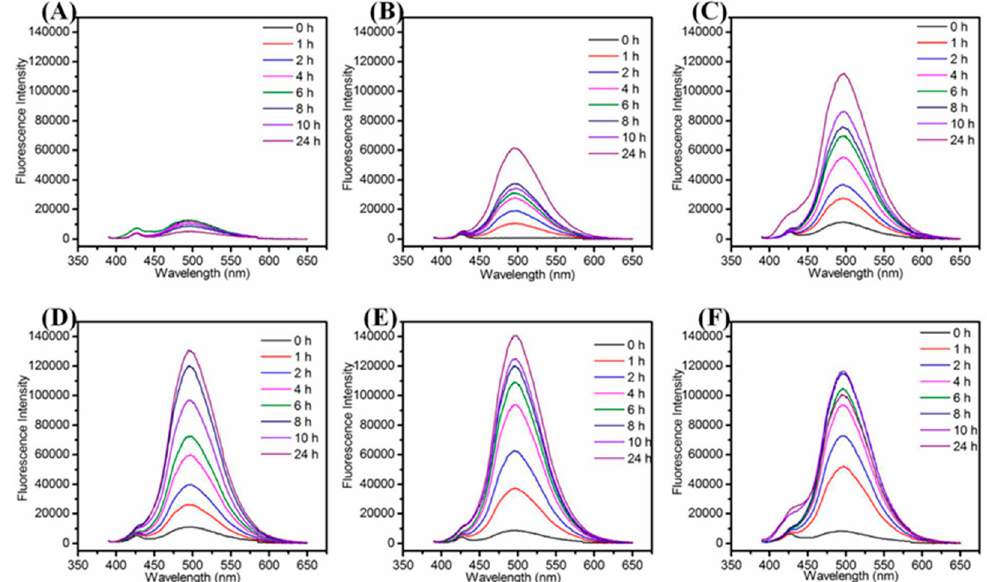
Figure 2. Fluorescence emission spectra of Cu NCs@GSH with the reaction time under different heating temperatures. ( A ) 25 °C; ( B ) 50 °C; ( C ) 60 °C; ( D ) 70 °C; ( E ) 80 °C; ( F ) 90 °C).